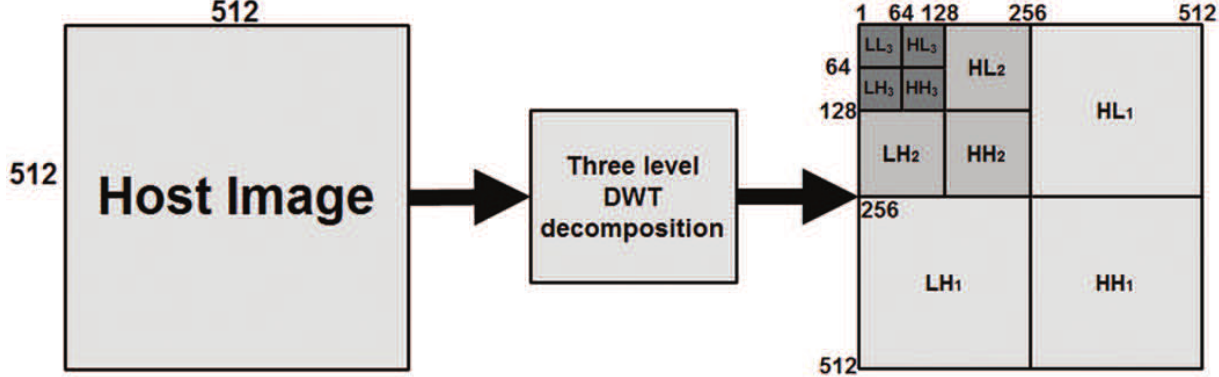
Figure 1: Three level decomposition layout of an